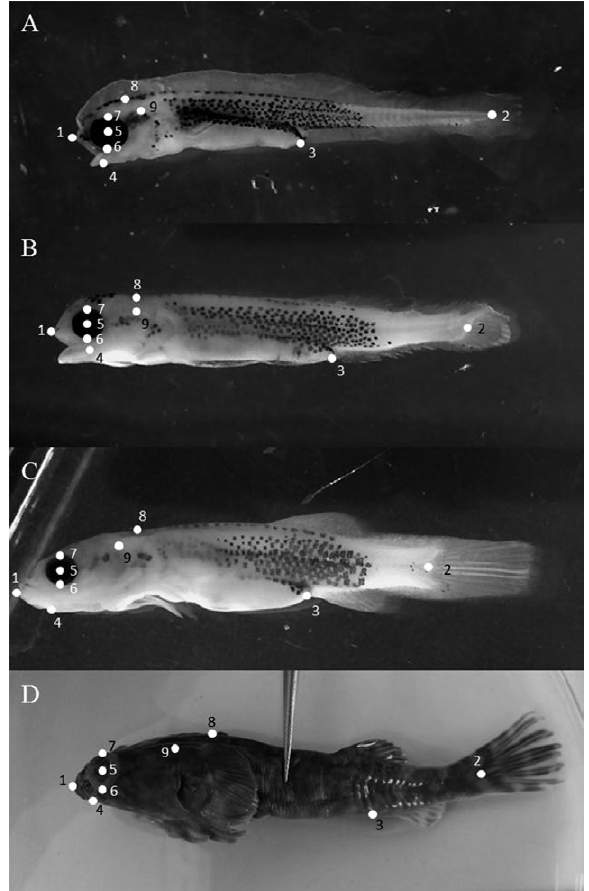
Fig. 1. – Landmark position in preflexion (A), flexion (B) and post- flexion larvae (C), and juveniles (D) of S. sanguineus , where 1, tip of the premaxilla; 2, posterior body extremity; 3, anus; 4, posterior extremity of premaxilla; 5 centre of the eye; 6 and 7, lower and upper margin of the eye; 8, posterior extremity of occiput; and 9, insertion of